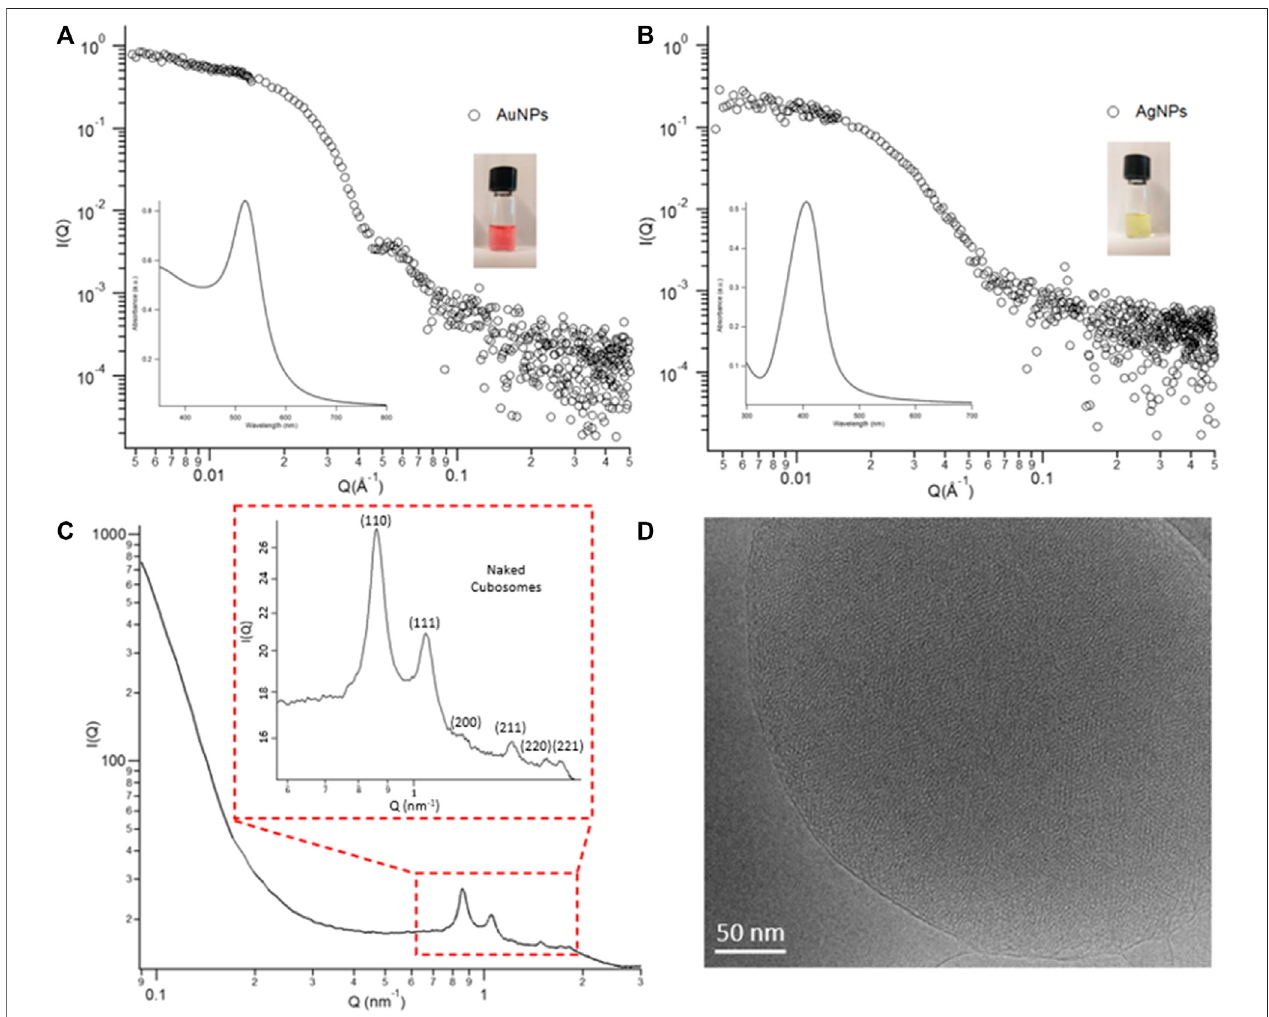
FIGURE 1 | Panel (A) Physicochemical properties of NPs. SAXS pro fi les and UV-vis spectra (insets) of AuNPs and AgNPs in water (at a concentration of 8.3 × 10 − 10 M). Panel (B) Structural characterization of cubosomes. (C) SAXS pro fi le of cubosomes in water at a GMO concentration of 4 mg/ml. The inset depicts the inner cubic Pn3m structure of cubosomes. (D) Representative Cryo-TEM image of the Pn3m inner architecture of cubosomes.